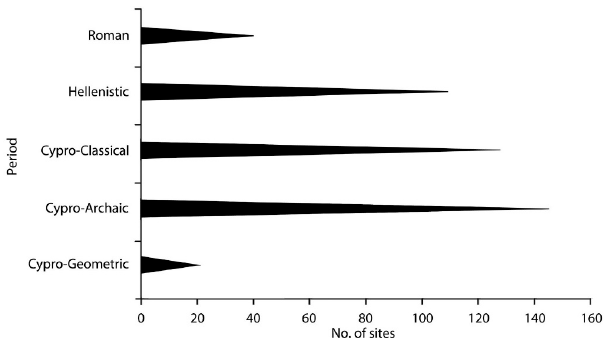
Figure 2. Density of sanctuary sites from the Cypro-Geometric to the Roman period (graph and data by G. Papantoniou).